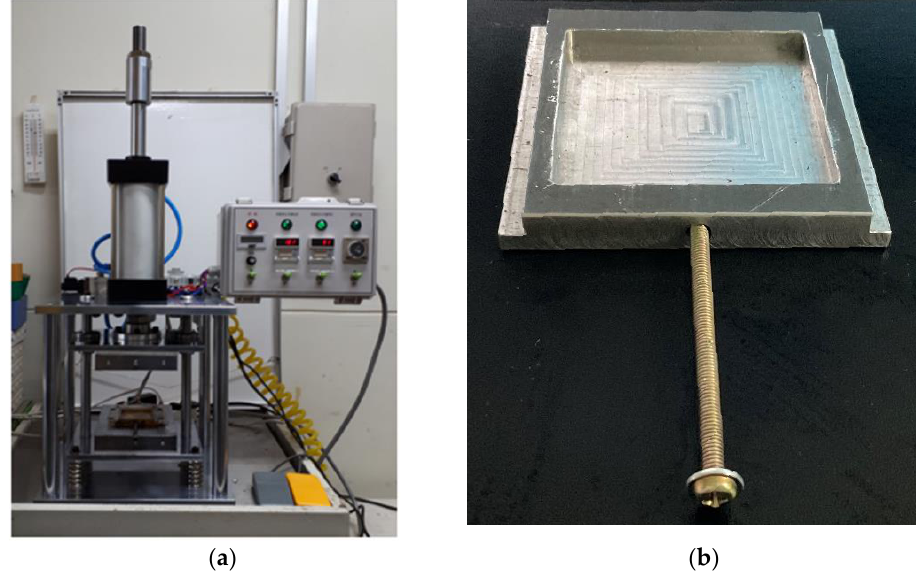
Figure 3. Experiment equipment: ( a ) compression molding and ( b ) compression-molding jig.